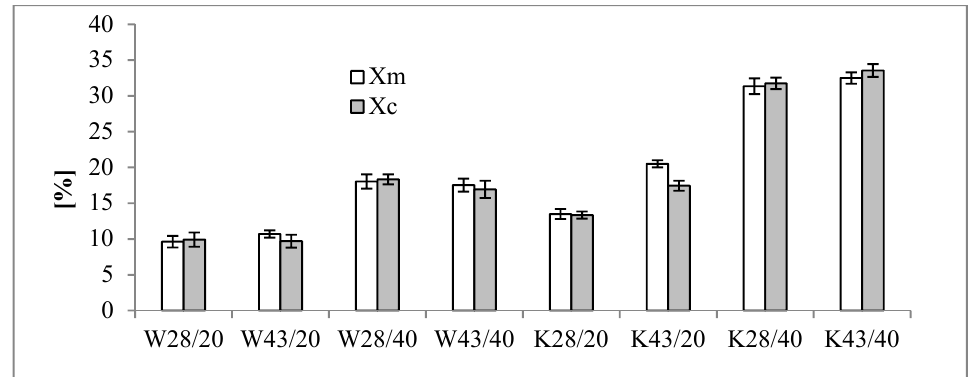
Figure 3. Coefficient of thermal efficiency of melting ( X m ) and crystallization ( X c ) process fortextile materials modified with MPCM28 and MPCM43.